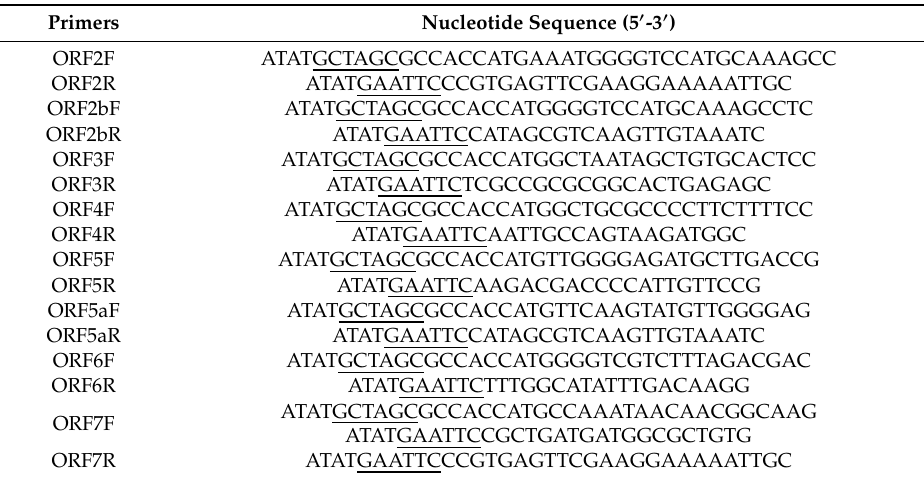
Table 1. Primers used in this